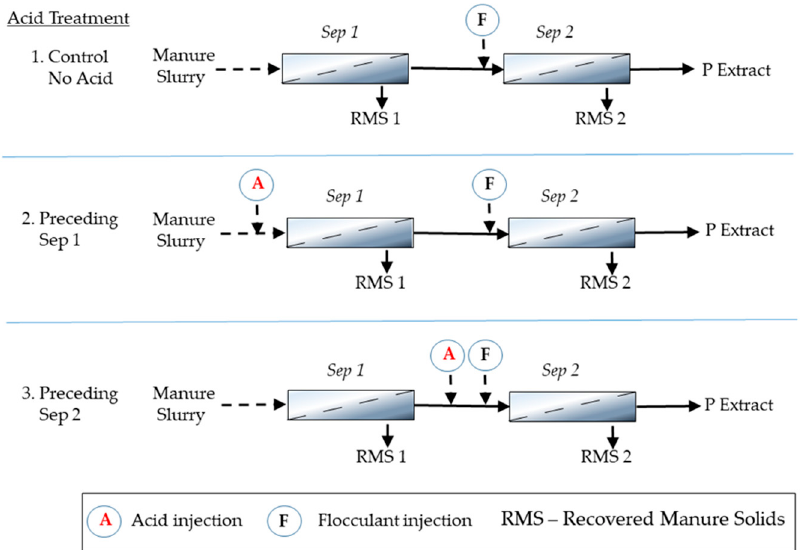
Figure 2. Schematic diagram of the three treatments tested for solids separation of manure using a double-stage stationary separator with two screens Sep 1 (12.7 mm) and Sep 2 (0.25 mm) and alternative points for acid injection for phosphorus (P) extraction.